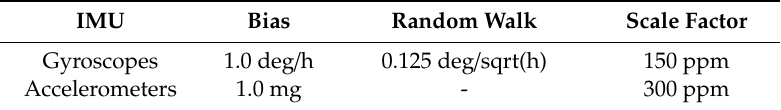
Table 1. The technical parameters of HG1700AG58.